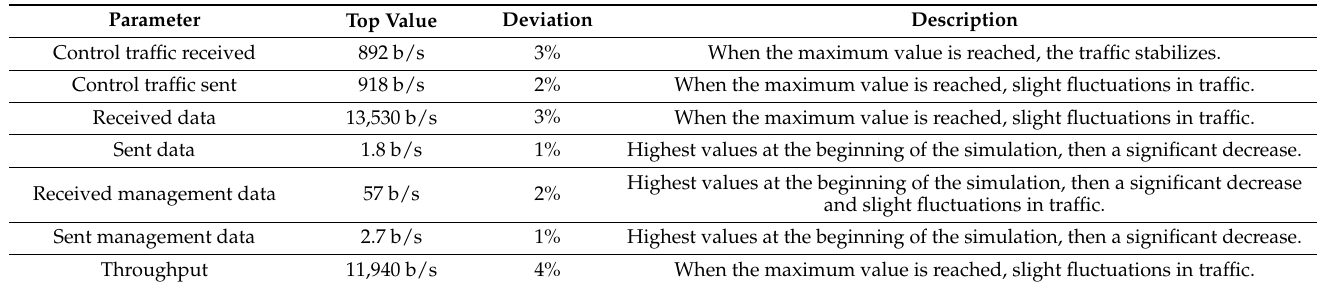
Table 4. The statistics of the network coordinator in the first